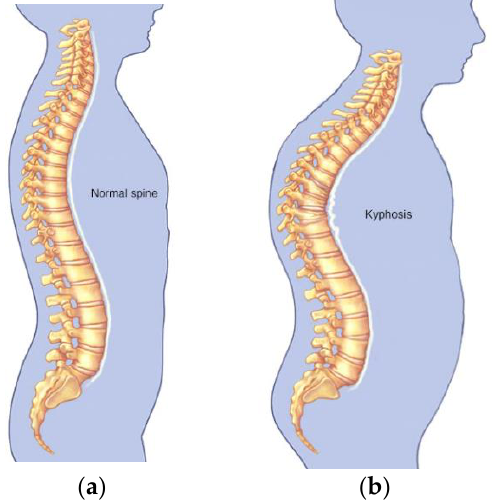
Figure 2. ( a ) A normal spine (without kyphosis); ( b ) Patient with abnormal spine (kyphosis).